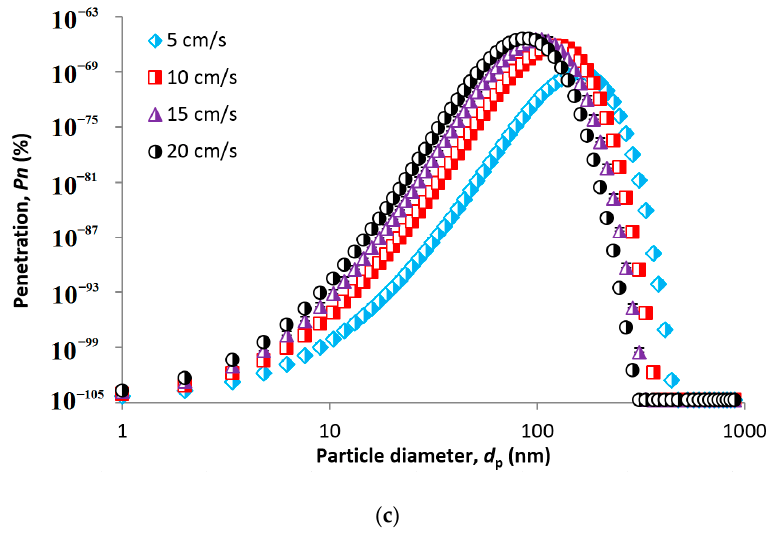
Figure 9. Single collector efficiency ( a ), overall filter efficiency ( b ) and overall penetration ( c ).